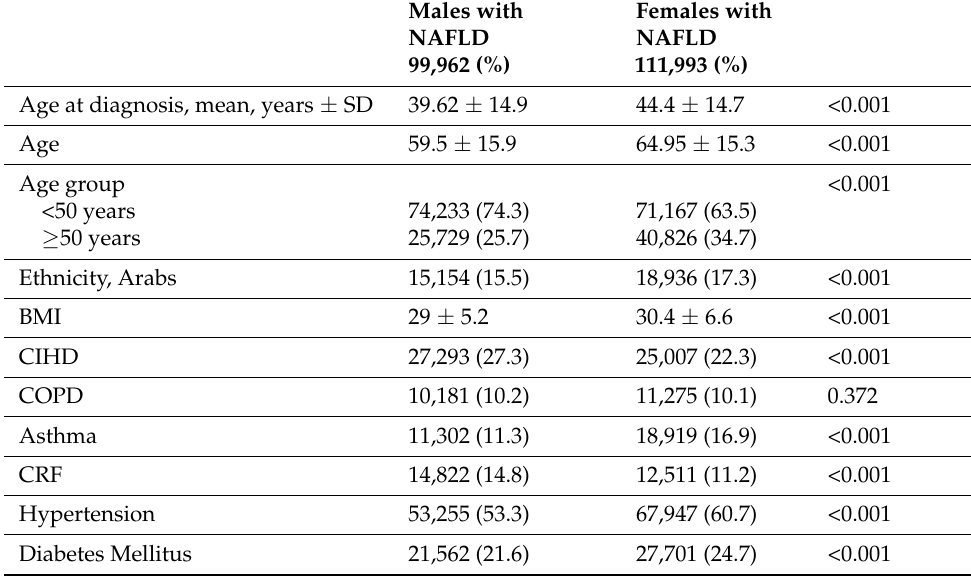
Table 1. Baseline characteristics, comorbidities, and malignancy among the study groups.